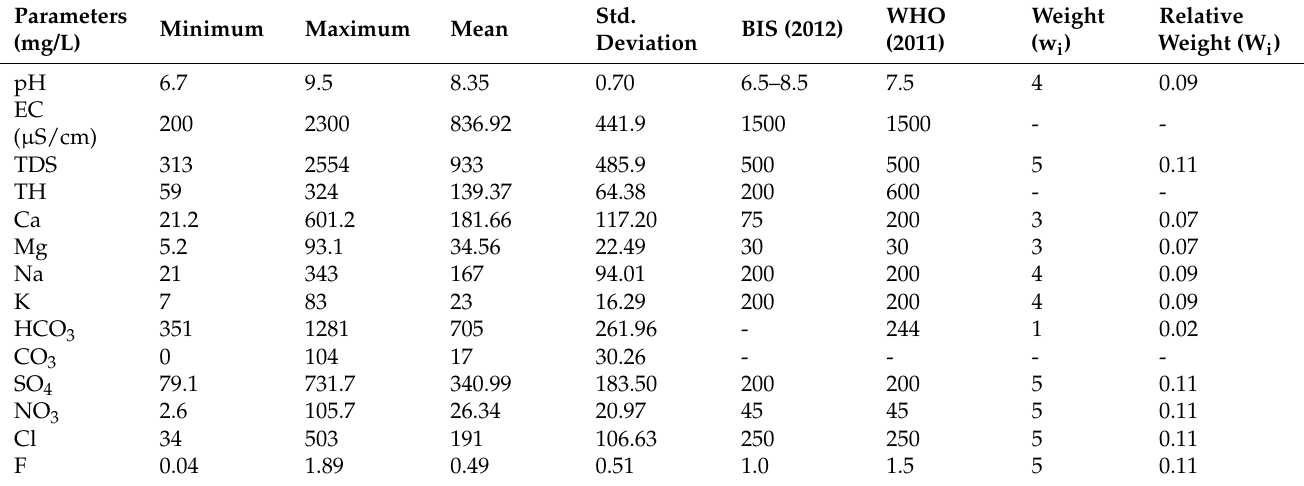
Table 2. Descriptive statistics of water quality parameters in